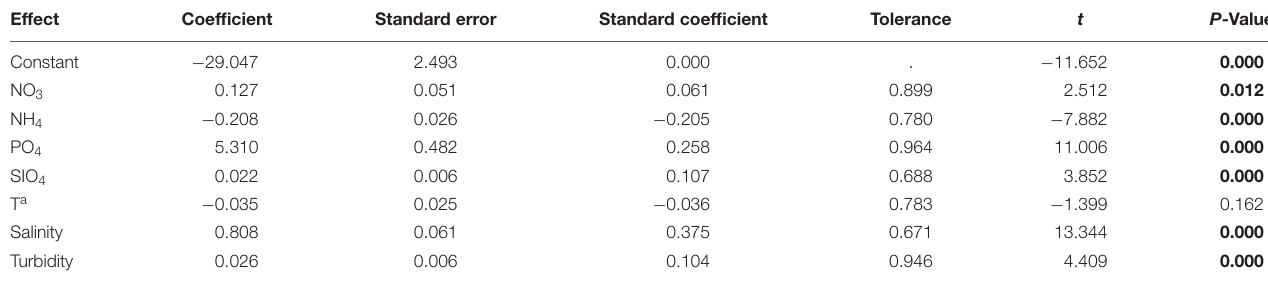
TABLE 7 | Results of the multiple regression analyses with forward selection of variables performed on complete matrix of sampling stations to explain Chl a concentration in the water column in the Mar Menor lagoon during the last 22 years (1997–2018) using meteorological, hydrographical, and nutrients as independent